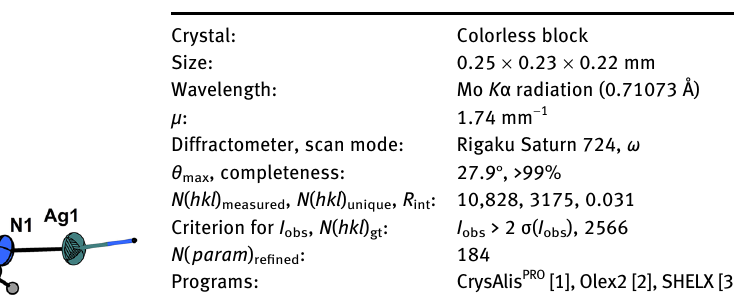
Table  : Data collection and